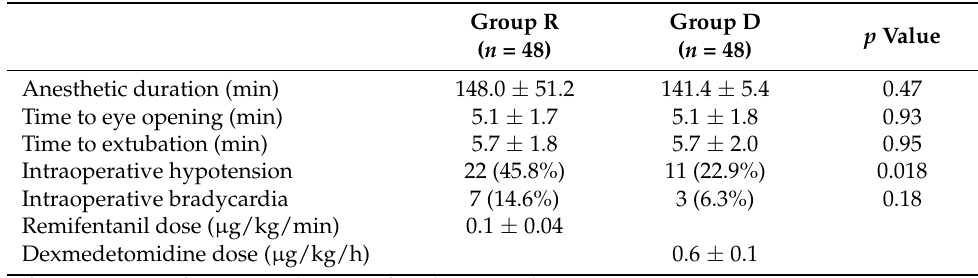
Table 2. Intraoperative